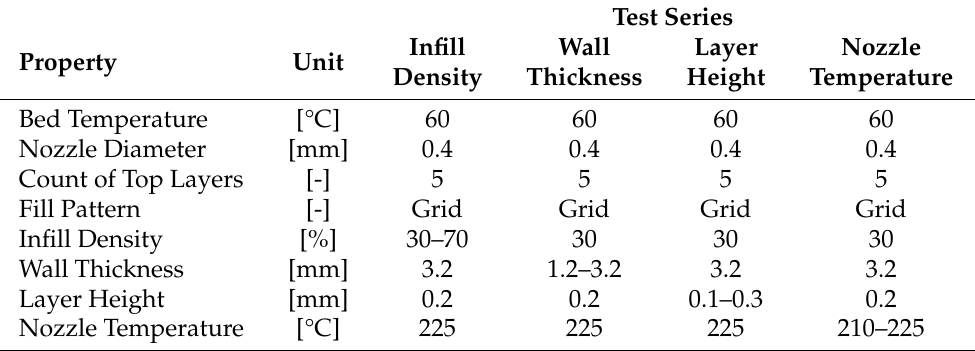
Table 2. The printing process parameters of the test series for the FLM test